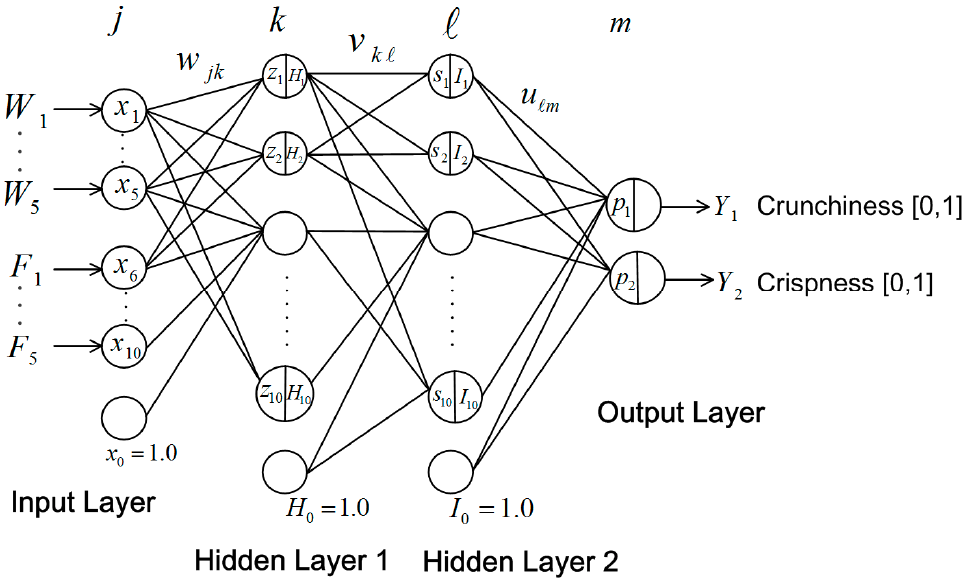
Figure 10. A neural network model for estimating food texture.